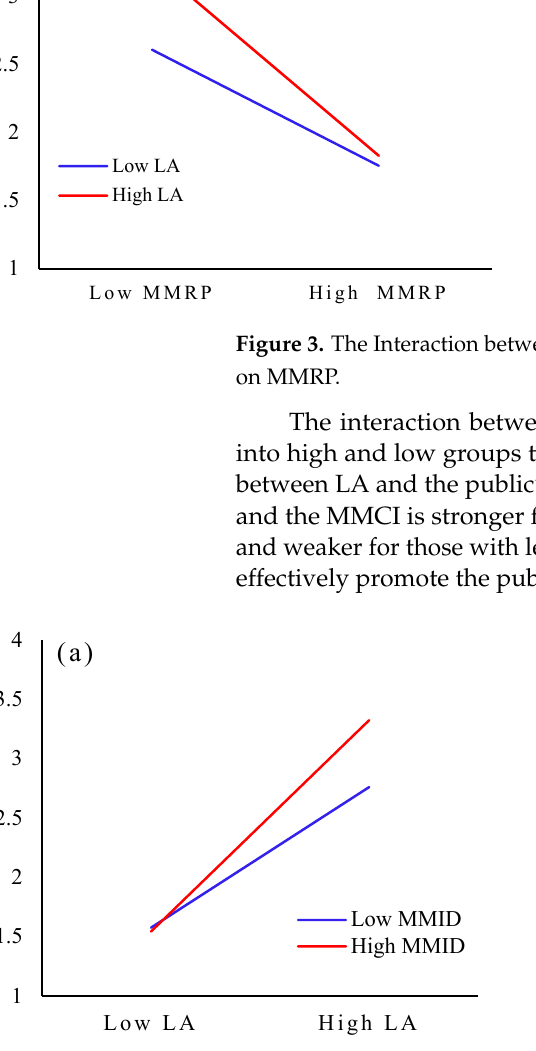
Figure 4. The interaction between MMID and LA and MMRP. ( a ) The effect of LA on MMID; ( b ) The effect of MMRP on MMID.